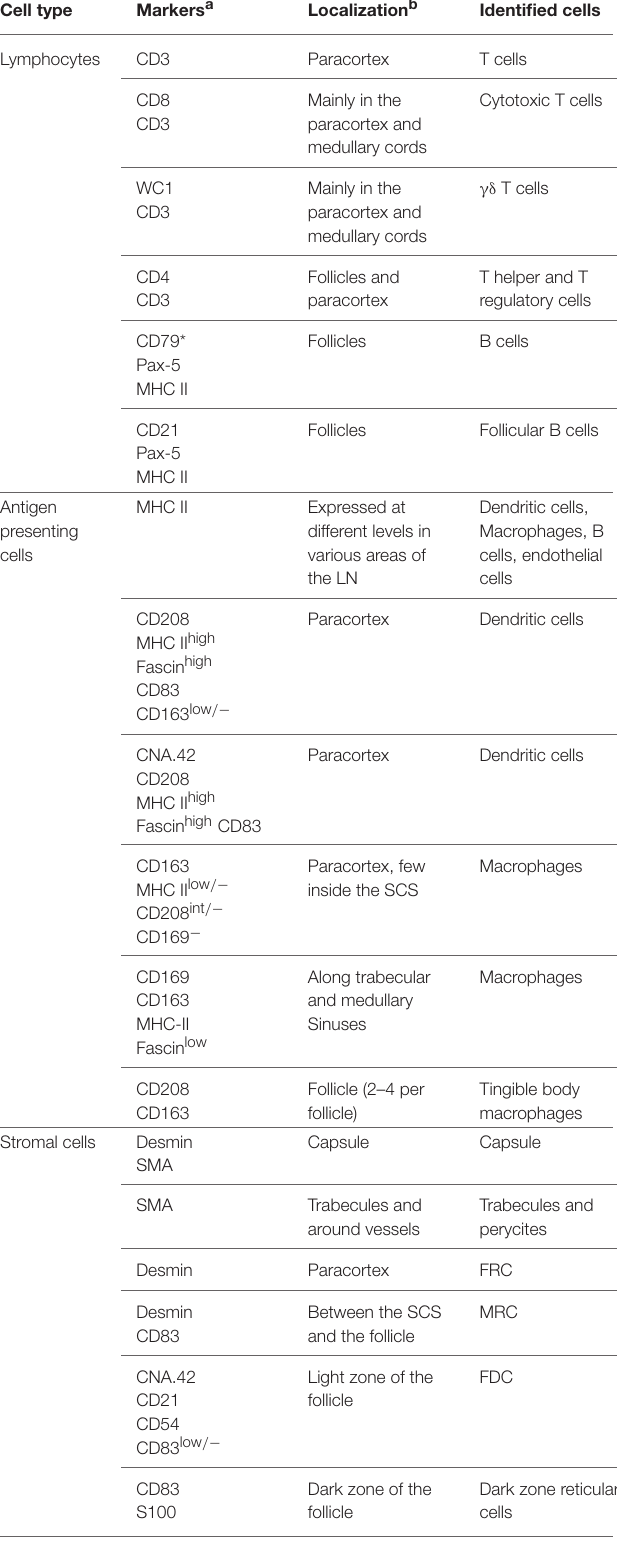
TABLE 2 | List of cell populations identified in this study in the sheep lymph node. Cell